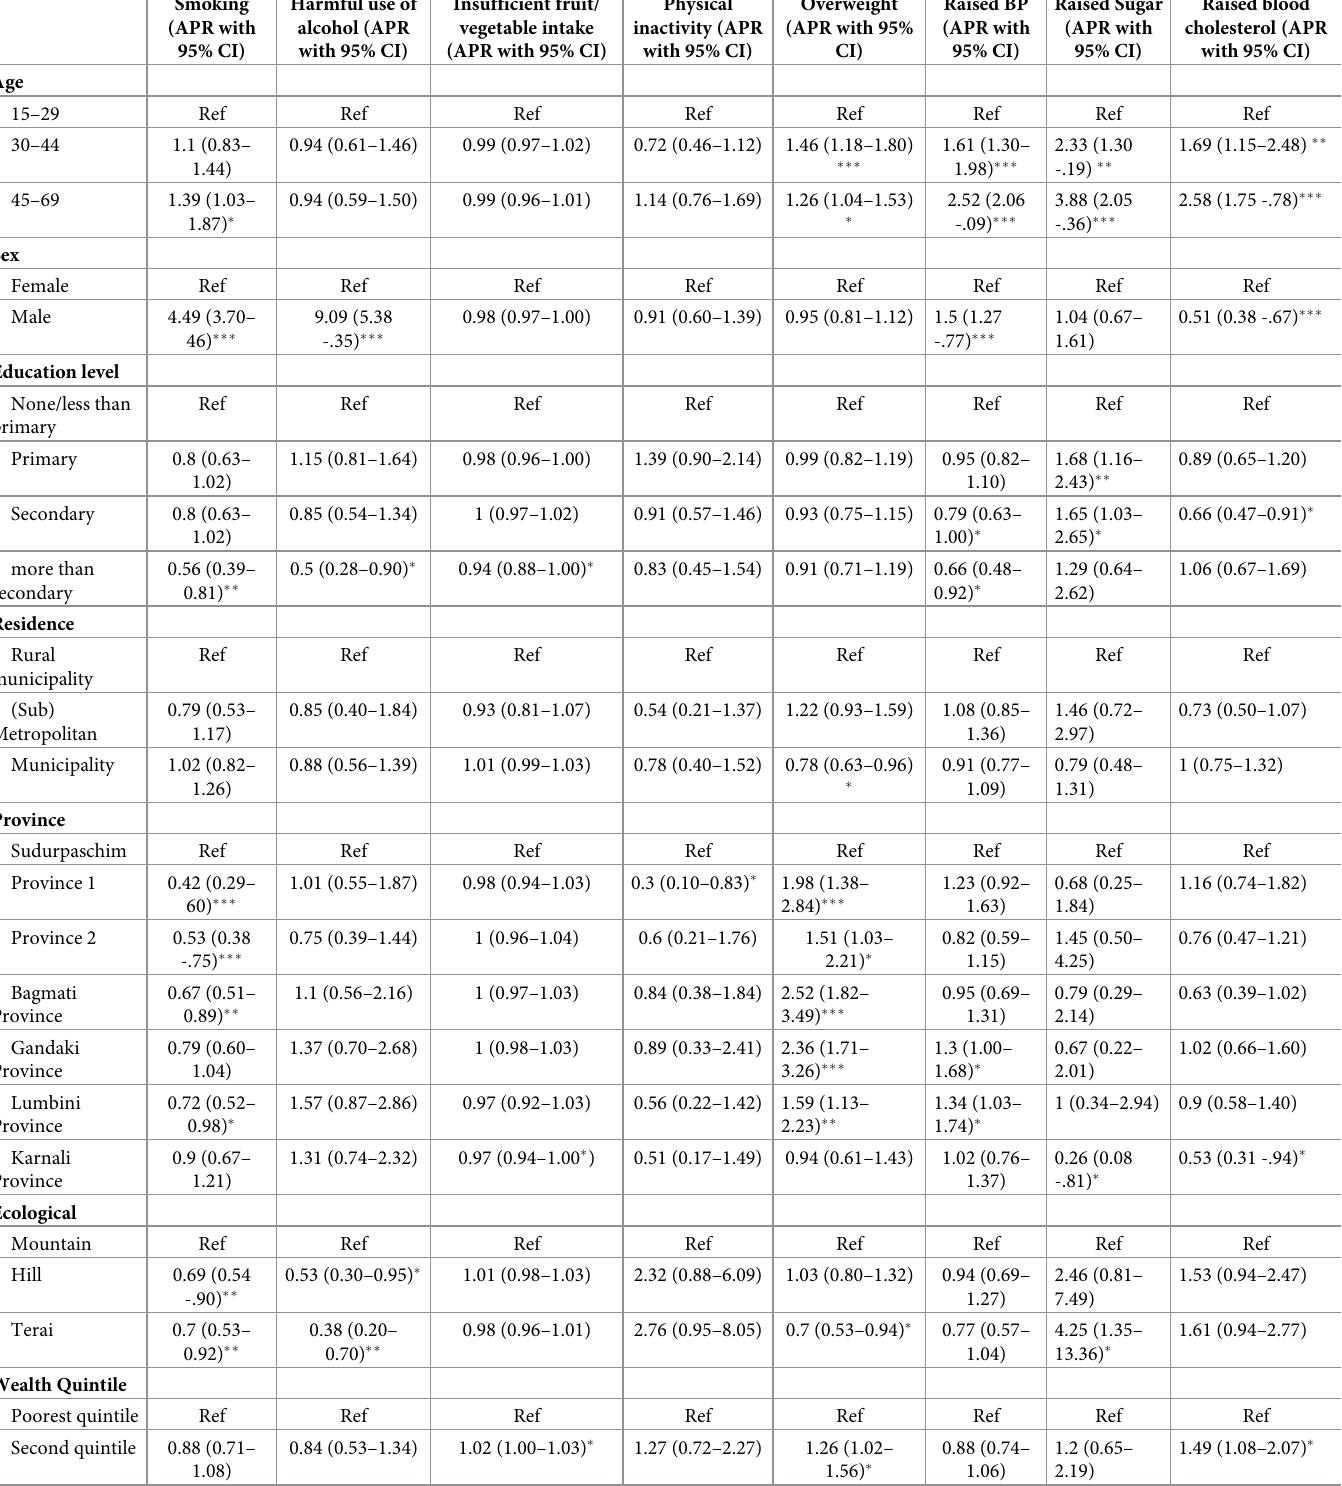
Table 3. Adjusted prevalence ratio of sociodemographic characteristics with NCD risk